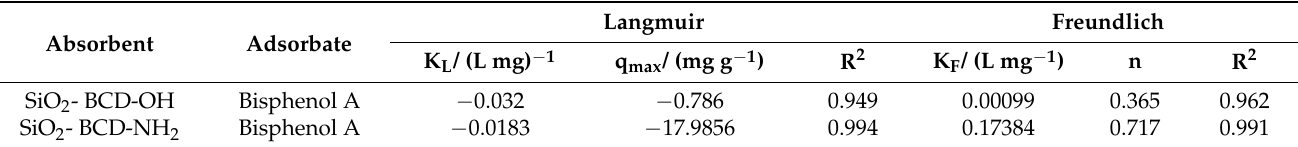
Figure 6. ( A , C ) Langmuir plots illustrating the linear dependences of 1/q e on 1/c e and ( B , D ) Freundlich plot illustrating the linear dependences of lnq e on lnc e for adsorption of bisphenol A by SiO 2 -BCD-OH and SiO 2 -BCD-NH 2 , respectively. Table 2. Isotherm parameters for the adsorption of bisphenol A by SiO 2 -BCD-OH and SiO 2 -BCD -NH 2 .